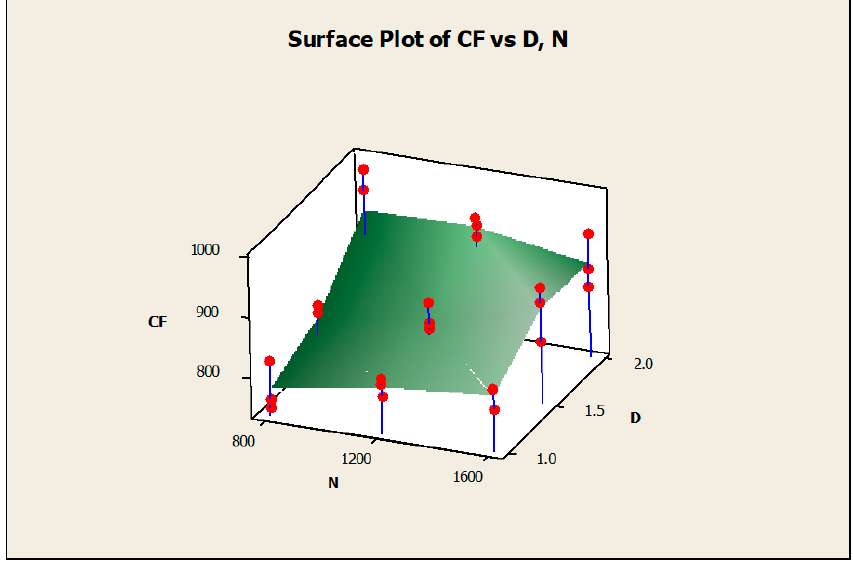
Figure 17. Surface diagram of CF with respect to N and D.